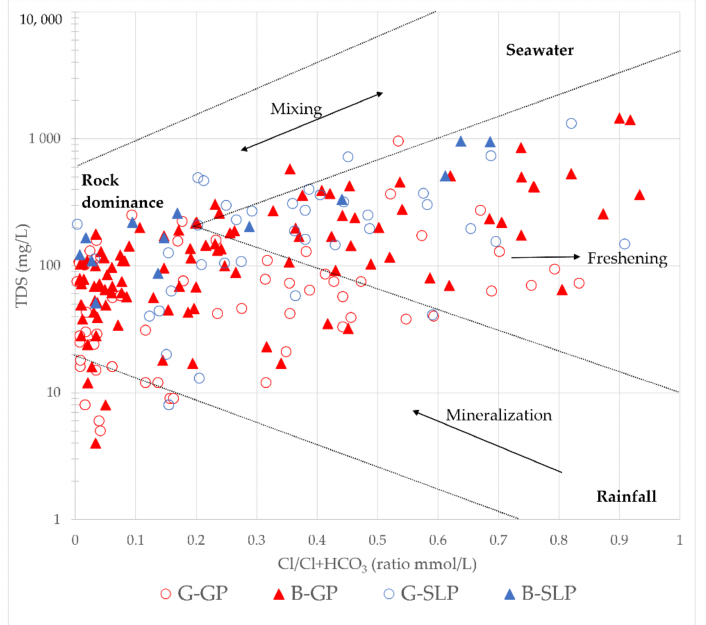
Figure 9. Gibbs’s diagram of the TDS concentration vs. the Cl/Cl+HCO 3 ratio to determine the main process influencing groundwater evolution. Samples are classified according to their geological province and aquifer type. GP, Grenville Province; SLP, St. Lawrence Platform; G: granular aquifer; B: bedrock